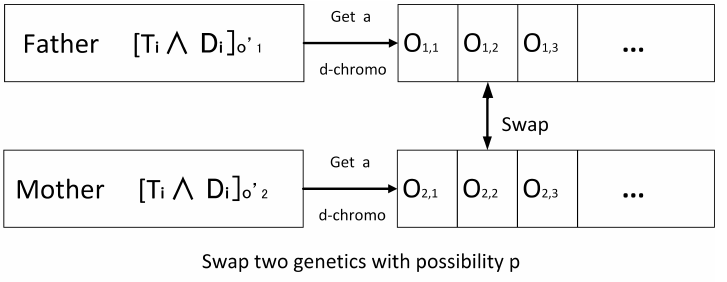
Figure 2. Crossover